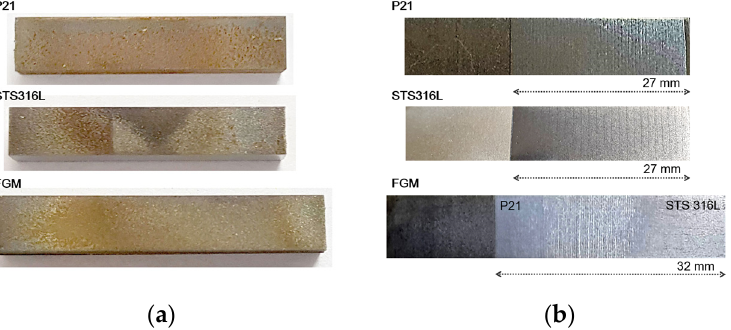
Figure 4. DED block macro images: ( a ) EDM wire cut blocks; ( b ) Mirror polished and etched blocks. 10mm thickness base plates were located on the left. Different colors appeared after etching due to differences in chemical compositions from DED stacked blocks.